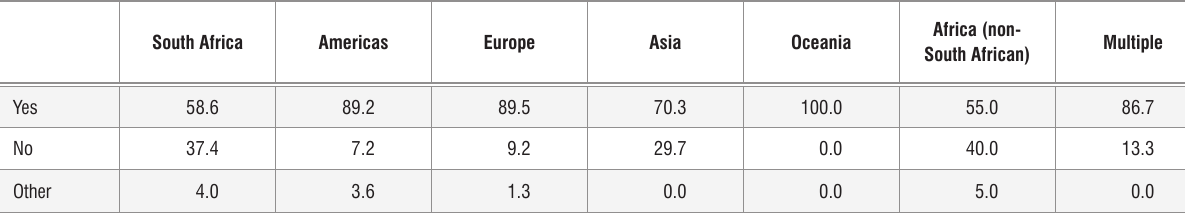
Percentage acceptance of human evolution by nationality ( n =705)